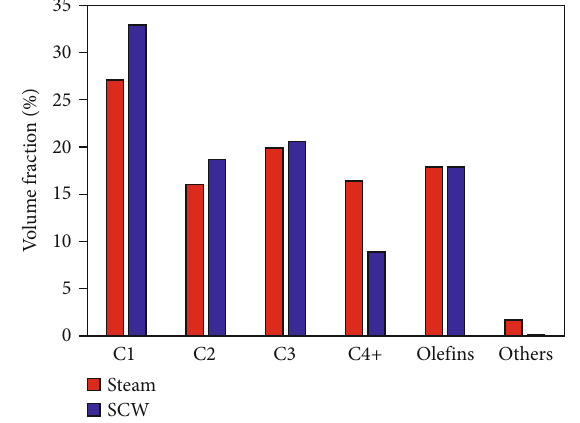
Figure 3: The composition of the gas